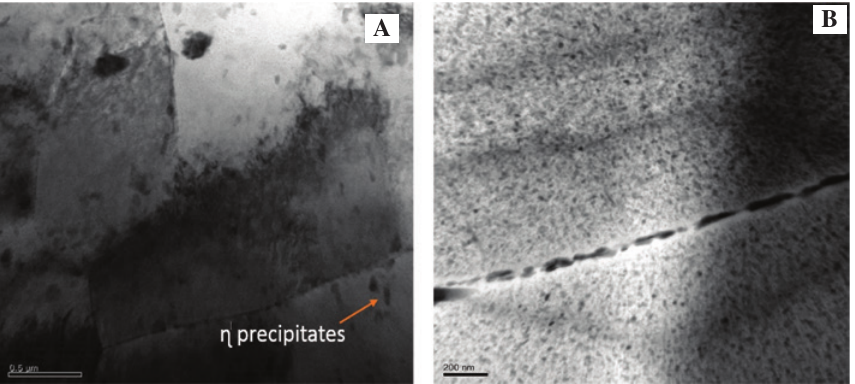
Figure 7: Microstructure evolution of the precipitate morphology of AA7075-T651. (A) Finer matrix precipitates. (B) Grain boundary precipitates.